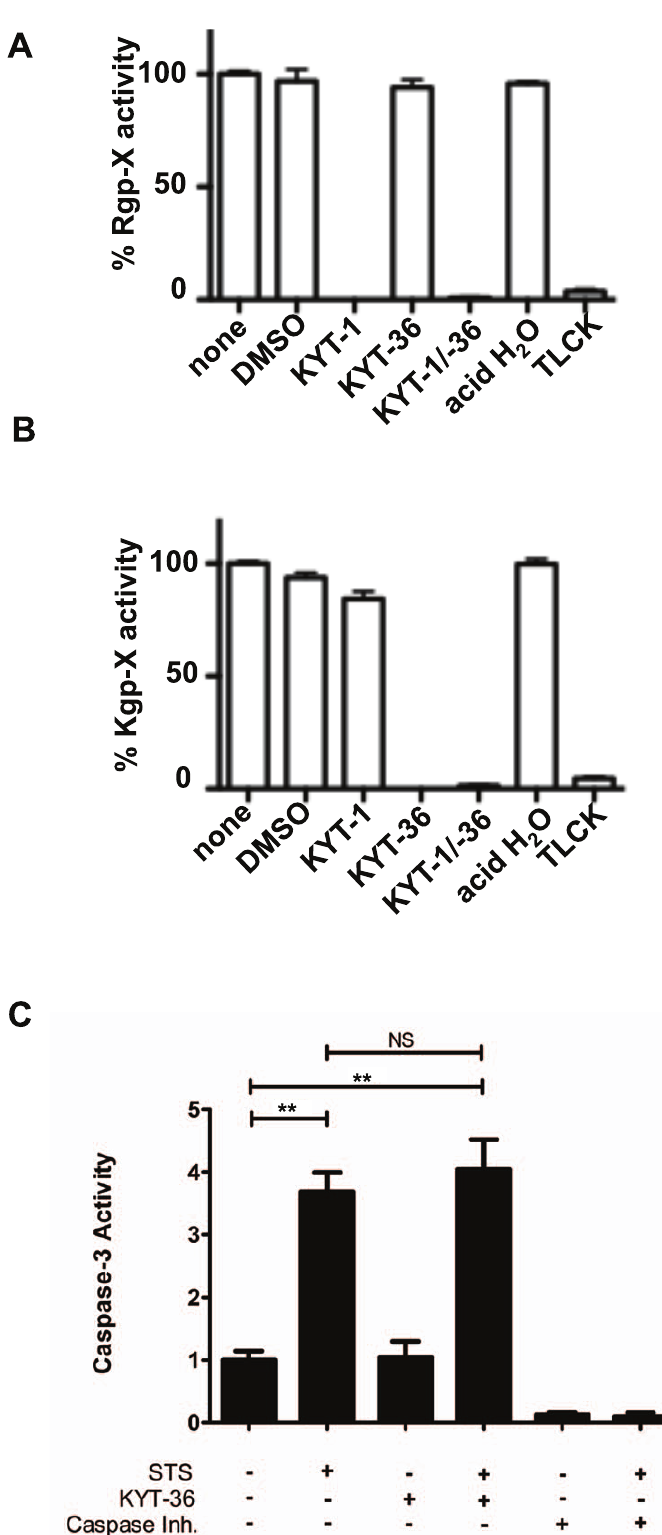
Figure 7. KYT inhibitors specifically inhibit P.gingivalis gingipain activity and do not alter host 3 caspase activity. Effect of gingipain inhibitors on P. gingivalis A ) Rgp or B ) Kgp protease activity. P. gingivalis was untreated (none) or pretreated with 10 m M Rgp-specific inhibitor KYT-1, 10 m M Kgp-specific inhibitor KYT-36, 10 m M KYT-1 and 10 m M KYT-36, 1 mM TLCK, or vehicle controls (DMSO or acid water) for 10 min and monitored for arginine-X-specific or lysine-X-specific protease activity. Effect of inhibitors on P. gingivalis is presented as percent Rgp-X activity or Kgp-X activity relative to untreated P. gingivalis . C ) HUVEC were untreated or treated with 2 m M staurosporine (STS) for 5 h. Whole cell lysates were analyzed for